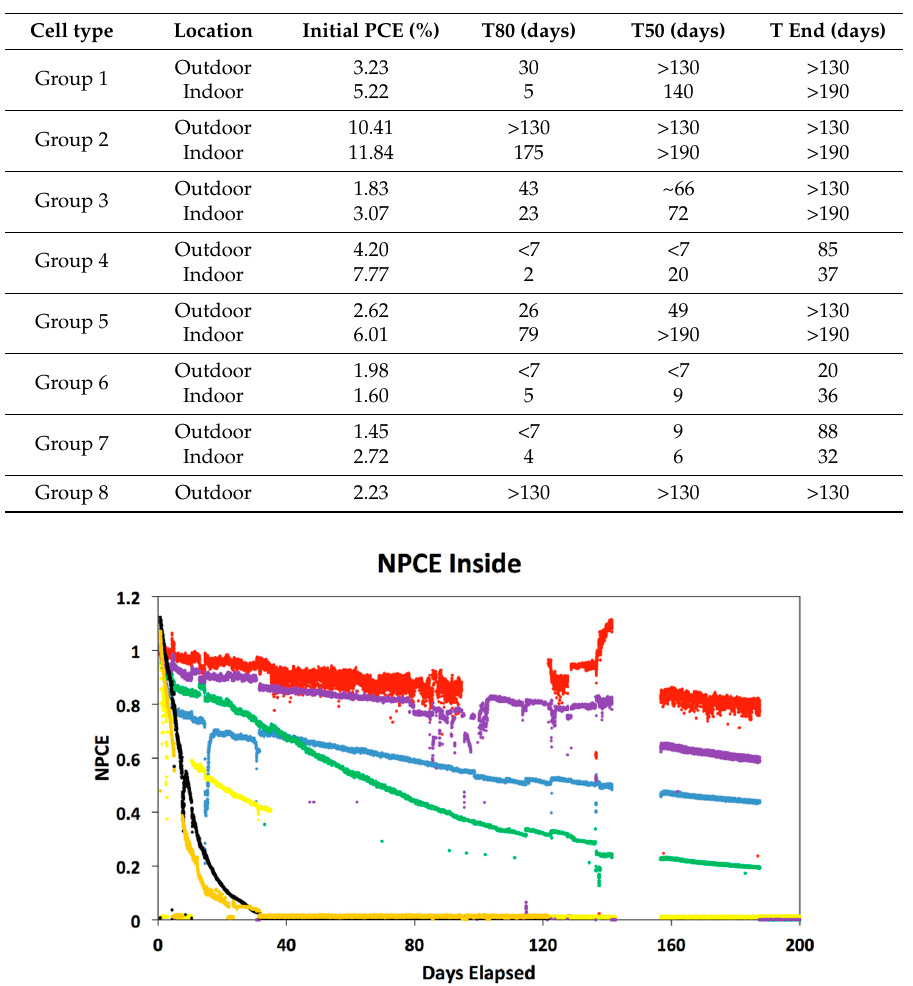
Figure 1. Graph displaying the indoor normalized power conversion efficiency (NPCE) curves for cells from Groups 1–7. Colors correspond to labels in Table 1.